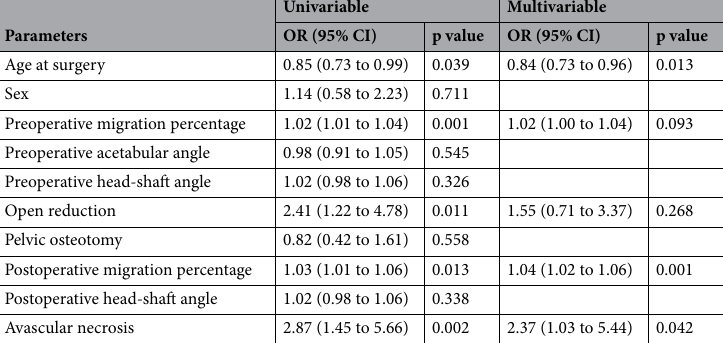
Table 4. Parameters associated with unsatisfactory outcomes at the final follow-up. Generalized estimating equations were used to calculate the ORs and CIs; OR odds ratio, CI confidence interval.